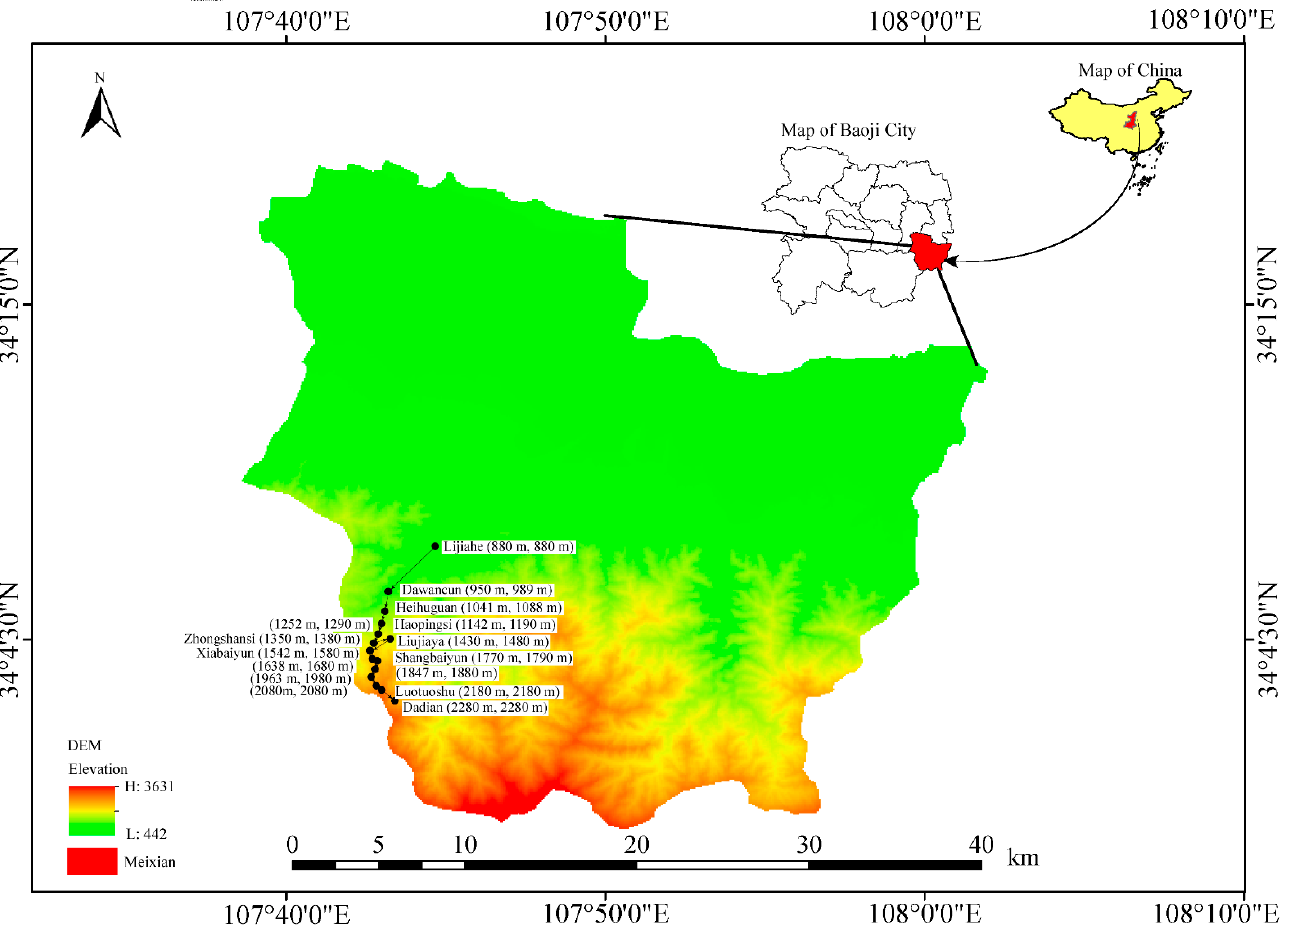
Figure 1. Sampling localities on Mount Taibai. DEM (Digital Elevation Model) downloaded from the Geospatial Data Cloud (http://www.gscloud.cn/search, accessed on 2 November 2022). Solid circle in black indicates sampling sites at different elevations. Elevations in parentheses represent two replicates at same transect. Named sampling sites were labelled directly in the